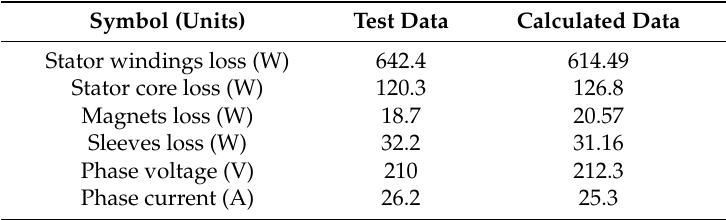
Table 2. Comparison of calculated results and test